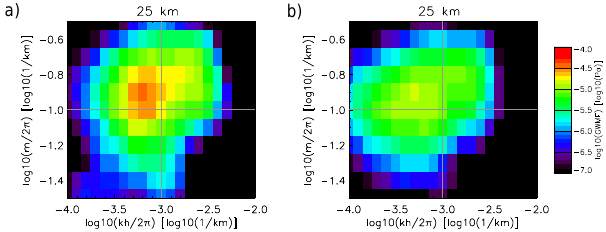
Figure B1. Gravity wave spectrum for period 1, 25km altitude, calculated from ECMWF data. The left panel shows the same spectrum as given in Figure 8e, the right panel shows the spectrum after application of the observational filter. The following differences can be observed: 1.) the intensity is generally reduced by roughlyafactorof2, 2.) forshorthorizontalandshortverticalwavelengthsthereductionisevenmuchstronger and 3.) for very long horizontal wavelength some GWMF is added due to the projection of the wavelength on the tangent point track. Black color indicates no wave events in the respective bin.